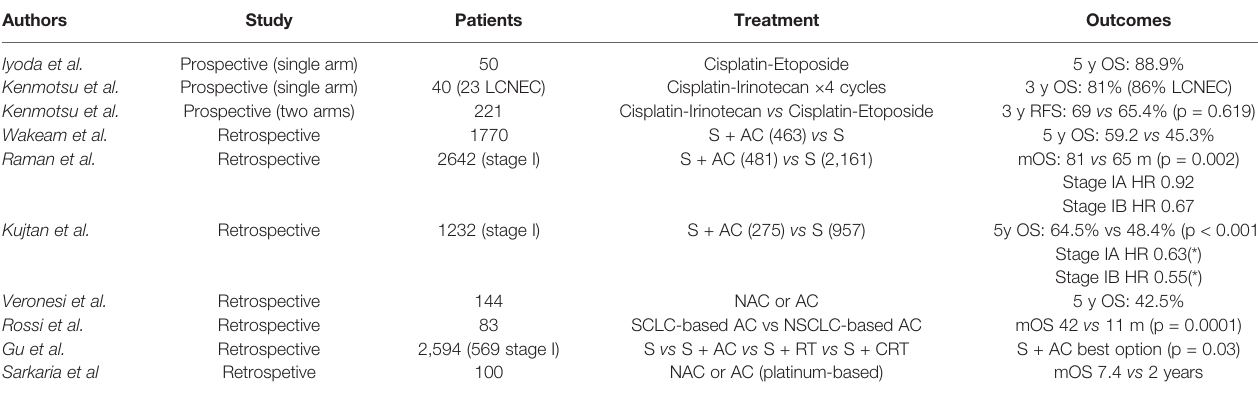
TABLE 2 | Available studies evaluating adjuvant chemotherapy in LCNEC.